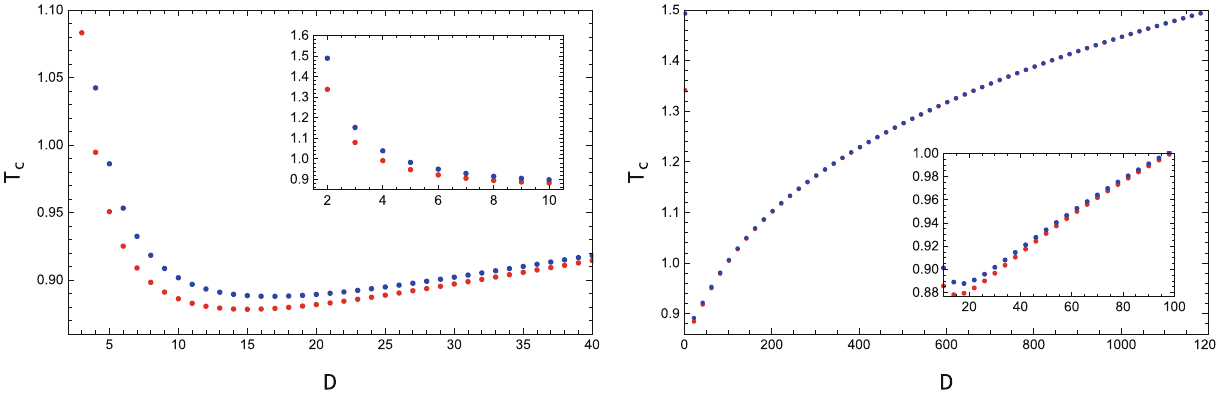
Fig. 2 D -dependence of the gap between T 1 , 2 against D ; the red and blue points represent T 1 and T 2 respectively, which are results evalu- ated with (33) and (37). We can see that the gap does not narrow even